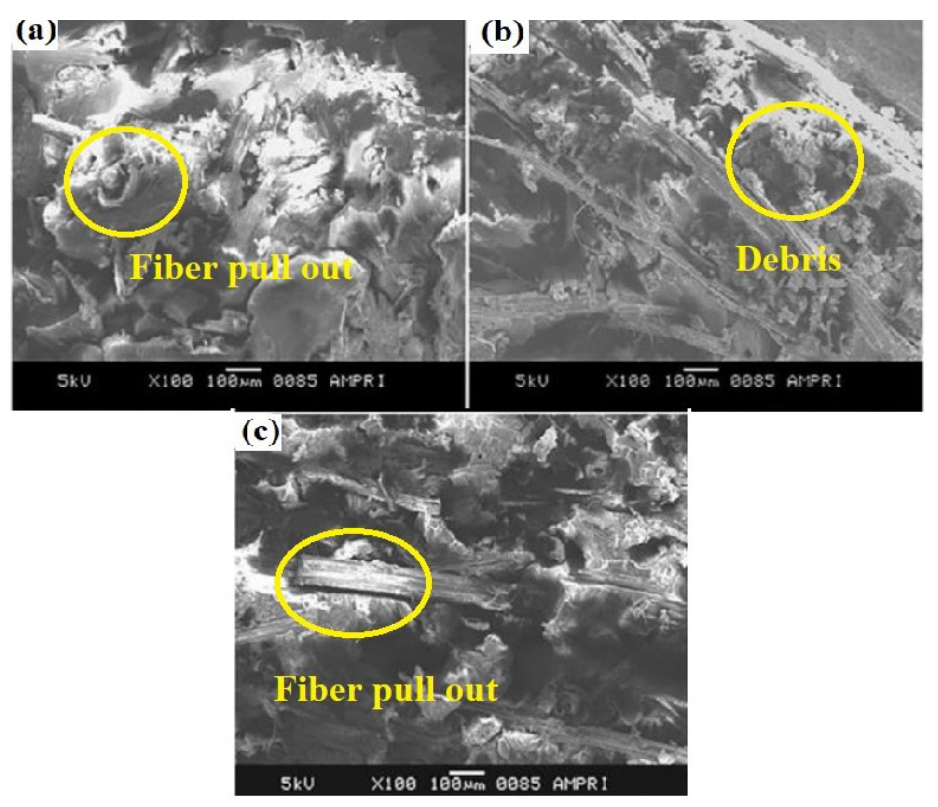
Figure 11. (a-c) SEM image of short fiber reinforced epoxy at 29.43N.